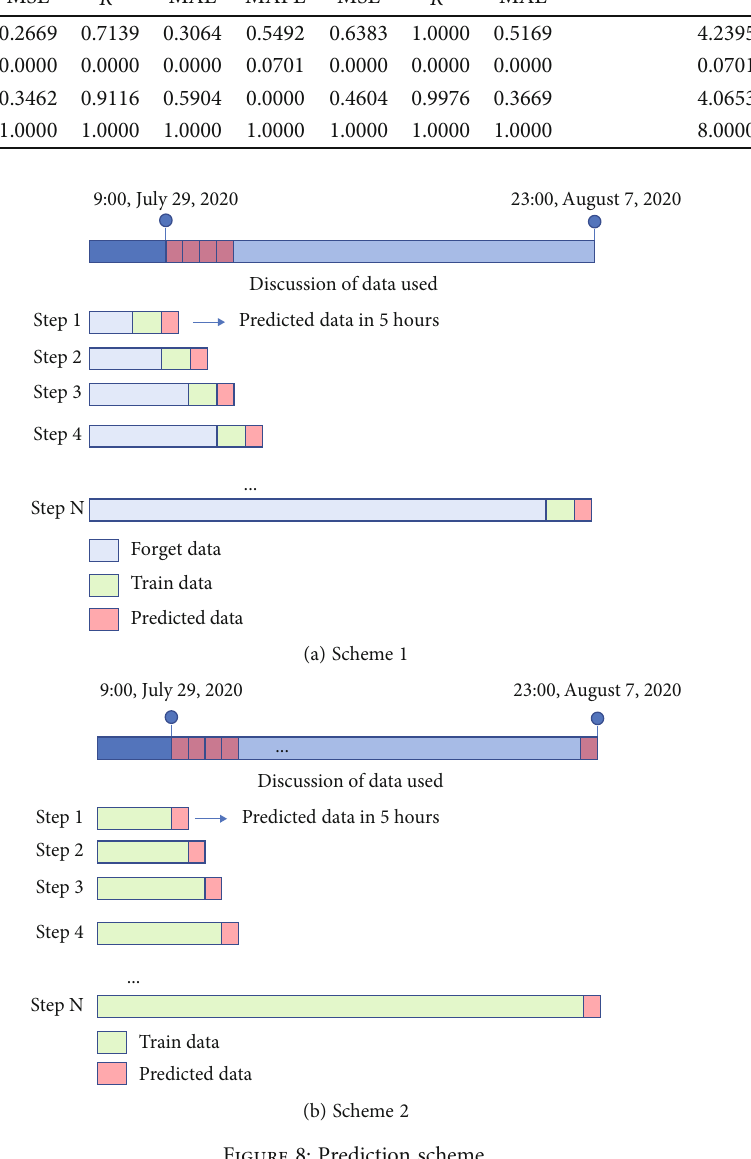
Figure 8: Prediction